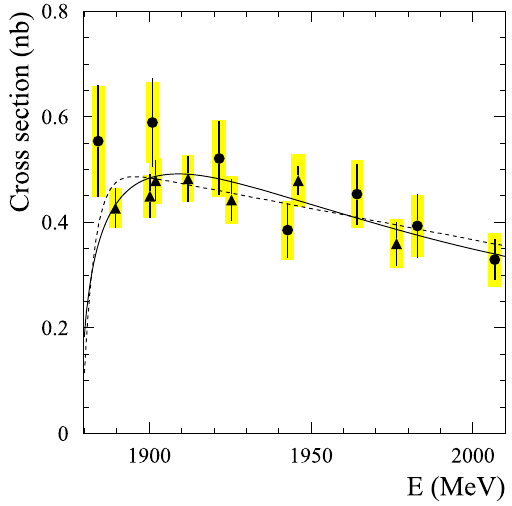
Fig. 13 The e + e − → n ¯ n cross section measured using the 2017 (cir- cles) and 2019 (triangles) data sets. The error bars and shaded boxes represent the statistical and systematic uncertainties, respectively. The solidanddashedcurvesarethefitresultsforModelIandII,respectively